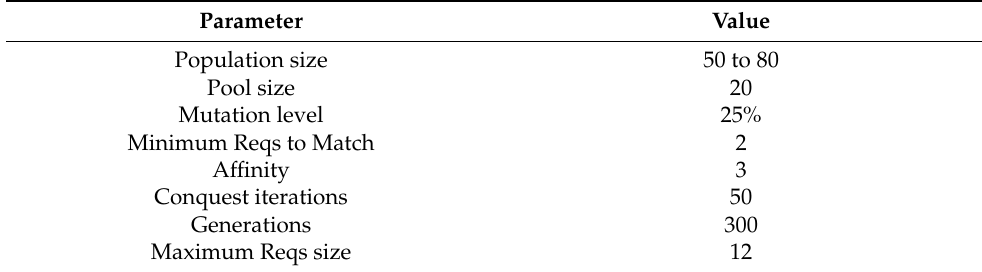
Table 6. Main GA parameters used in experiments.